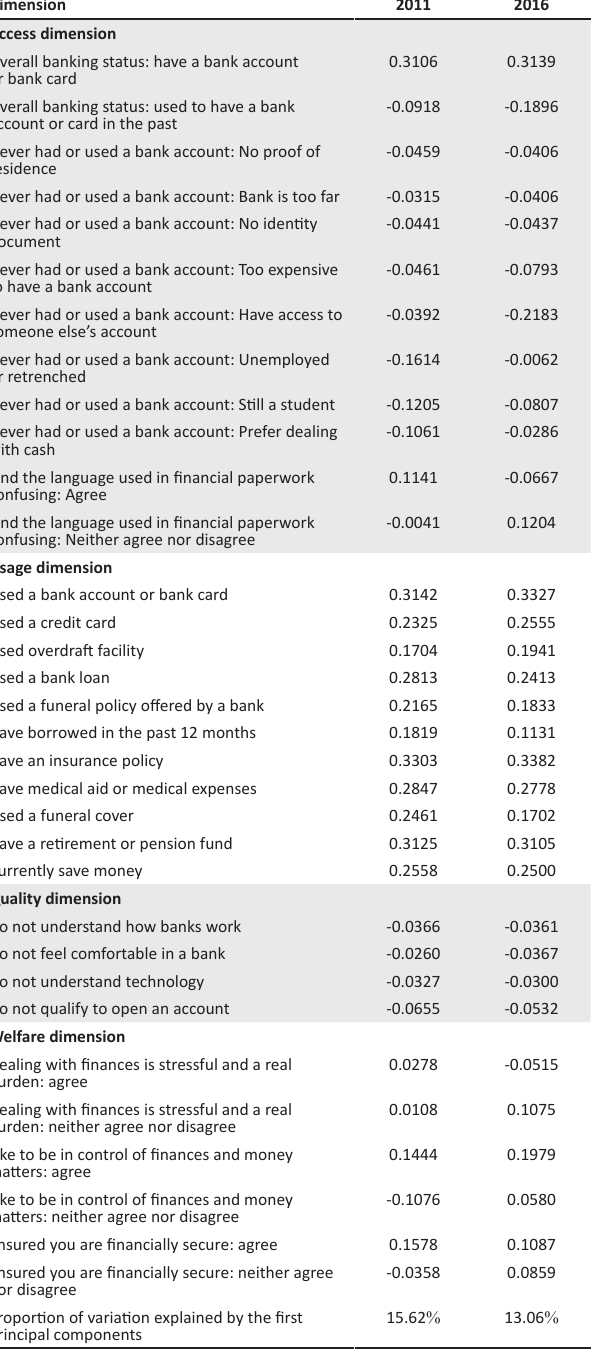
TABLE 3: First principal components for deriving the financial health